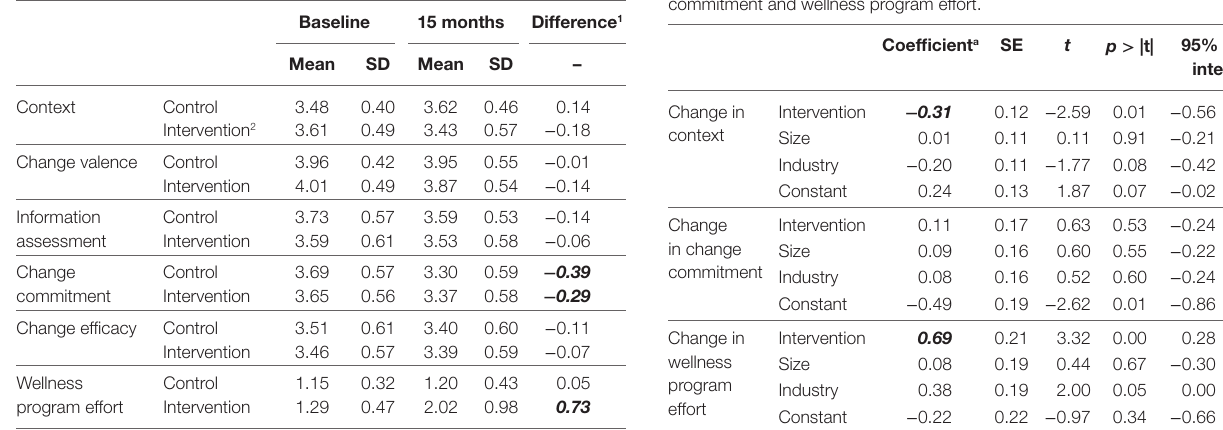
Table 4 | Change in organizational readiness to change factors between baseline and 15